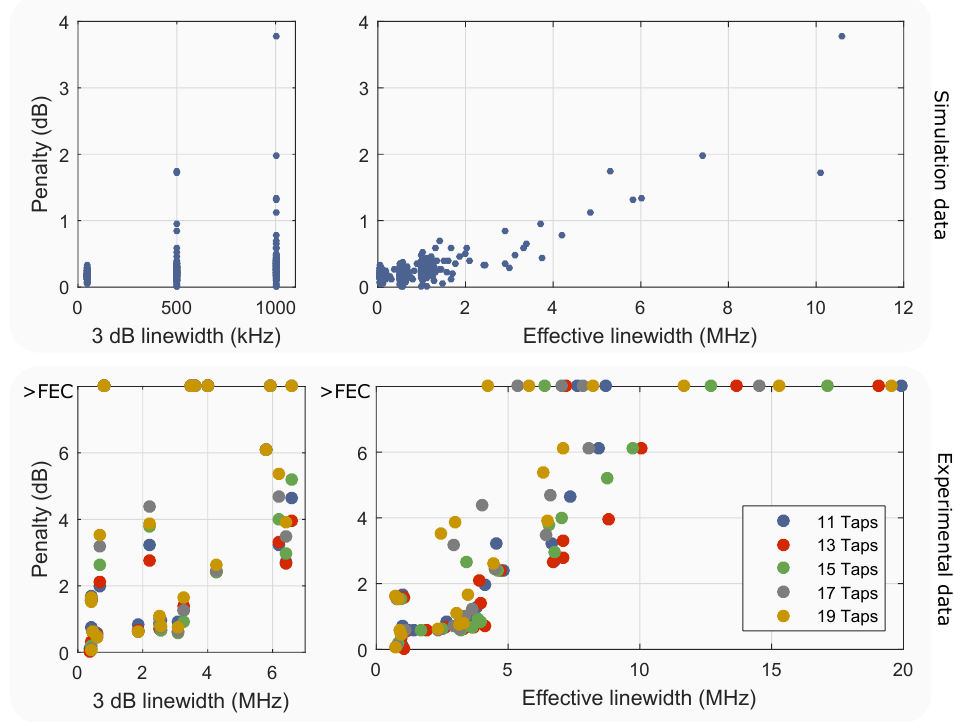
Figure 10. Comparison of system penalty vs. 3 dB linewidth ( left ) and effective linewidth ( right